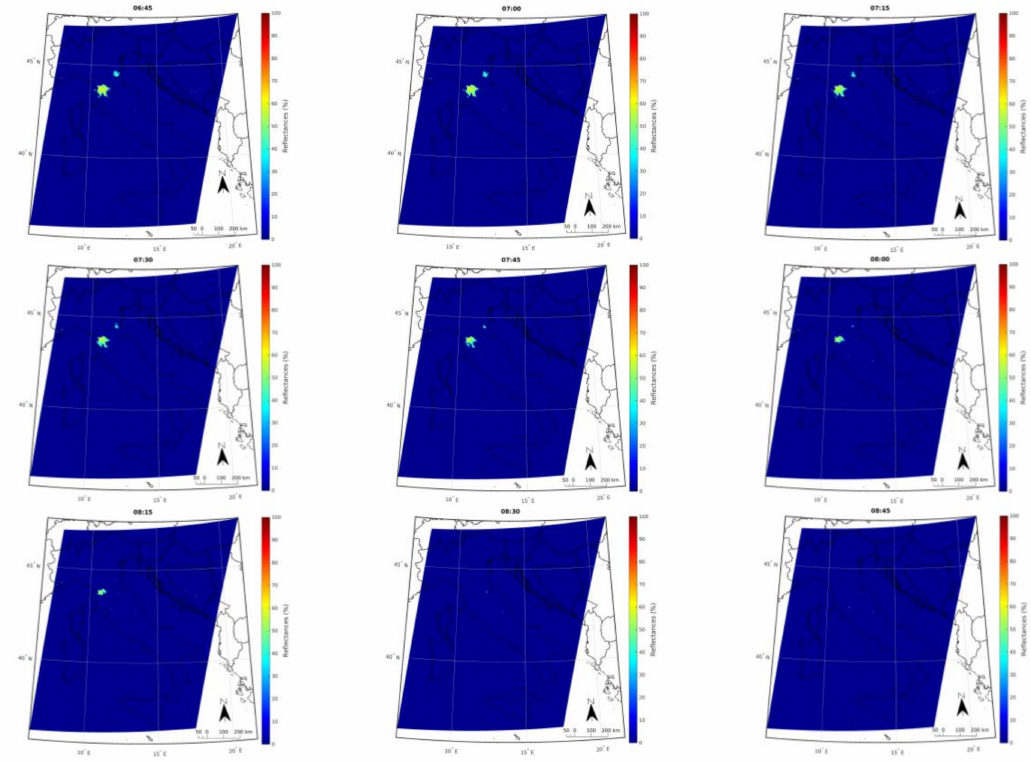
Figure 10. Fog temporal evolution detected by SatFog algorithm on 2017-04-10 between 06:45 and 08:30 UTC.